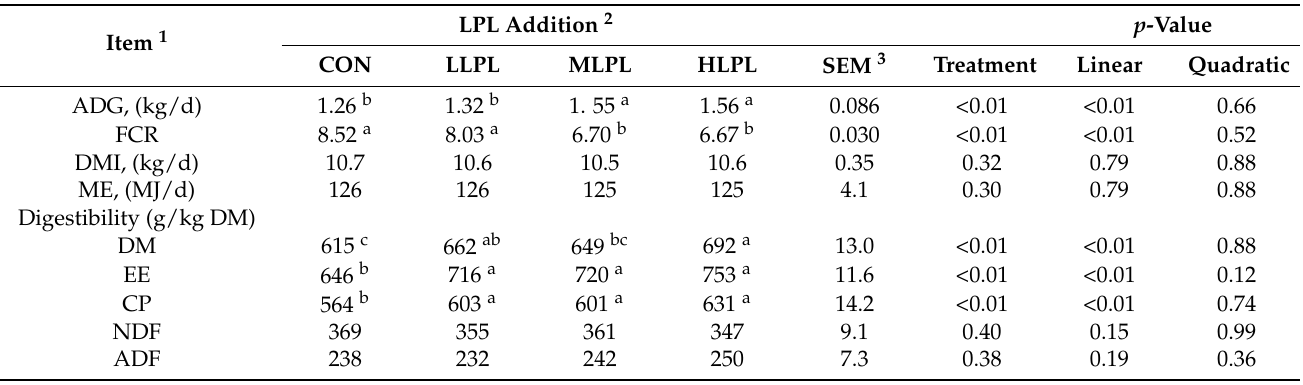
Table 2. Effect of dietary lysophospholipid supplementation on the feed intake, growth performance, and digestibility of beef cattle.